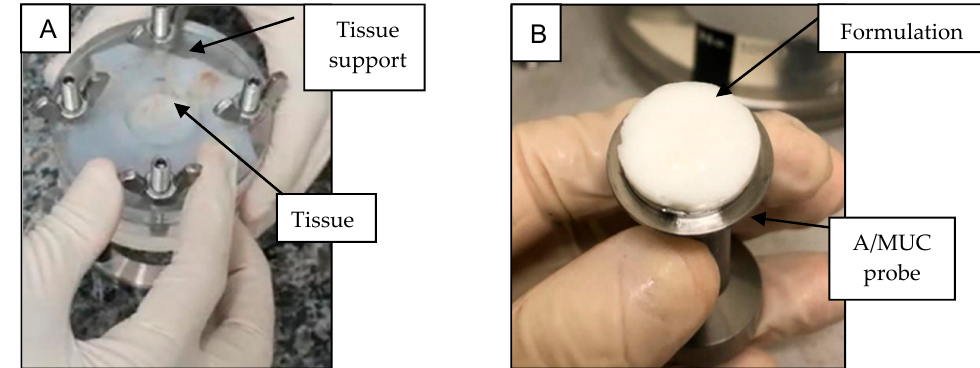
Figure 1. Preparation of the porcine nasal mucosa for the mucoadhesion test: ( A ) biological tissue fixed on the tissue support; ( B ) formulation fixed on the A/MUC probe.